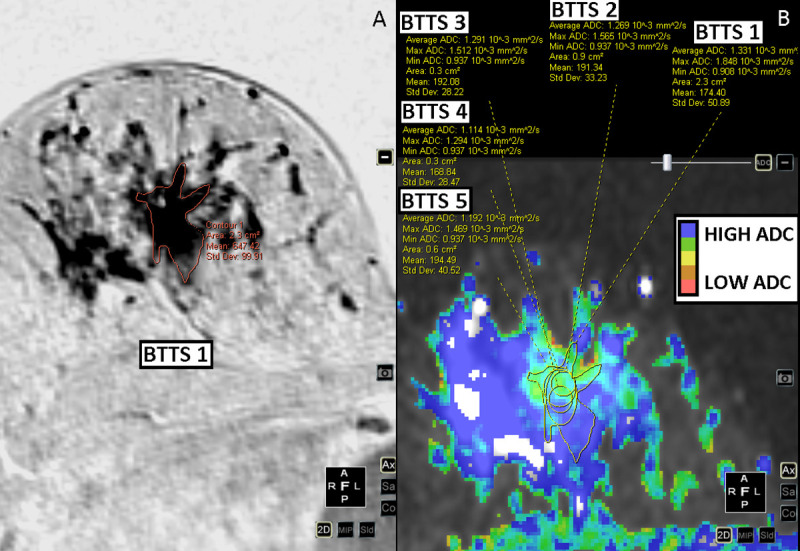
Sclerosing adenosis, columnar cell changes and apocrine hyperplasia of the right breast.MRI guided biopsy proven and unchanged in 4 years of follow-up. DCE-T1 subtracted images (inverted) (A) and DWI b0-1000 images (B). BTTS = Breast tumor tissue selection.